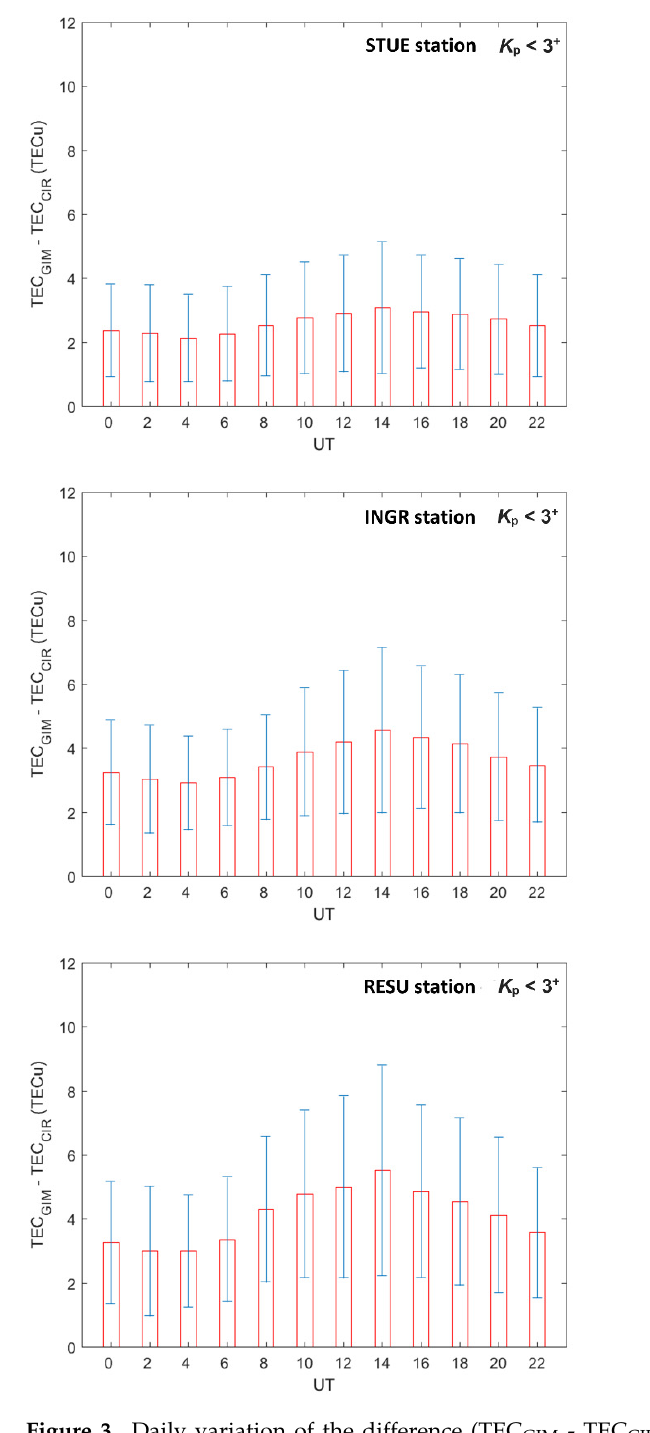
Figure 3. Daily variation of the difference (TEC GIM - TEC CIR ) in terms of hourly mean and corresponding standard deviation, with a time resolution of 2 h (corresponding with the time resolution of GIMs), for STUE (upper row), INGR (middle row) and RESU (lower row). Left panels refer to quiet geomagnetic values ( K p < 3 + ), while right panels refer to disturbed geomagnetic values ( K p ≥ 3 + ). For this analysis the LSA period (July 2008–June 2009) was joined to the HSA period (September 2013–August 2014).